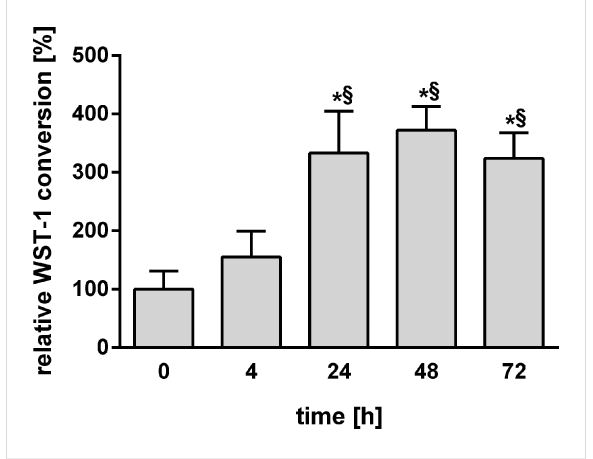
Figure 2: Viability of PCLS as determined by WST-1 conversion at 0, 4, 24, 48, and 72 h after preparation of PCLS ( n = 5; * p < 0.05 vs 0 h;